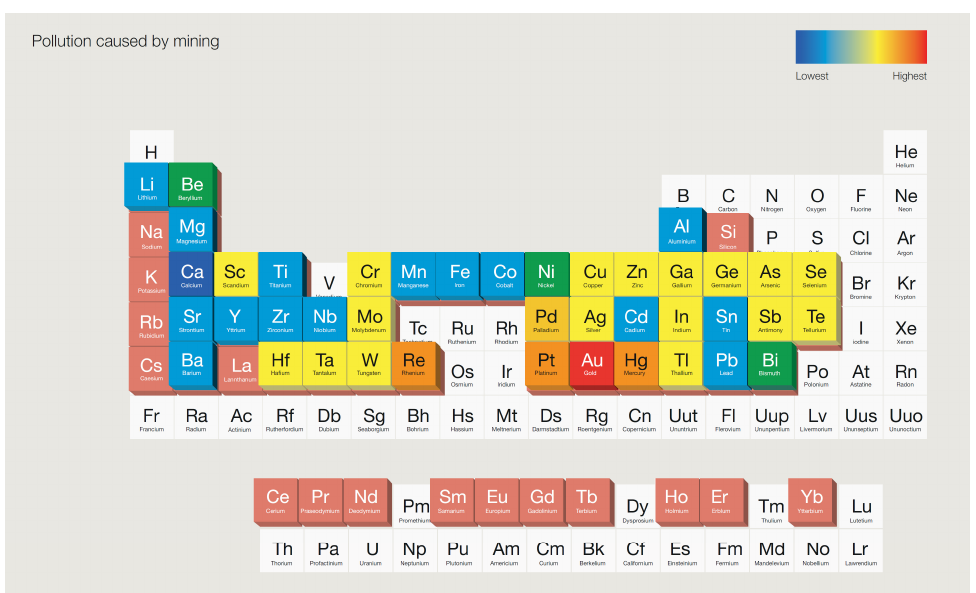
Figure 1. Periodic table depicting the pollution impact caused by mining of various elements. Reproduced with permission from [22].